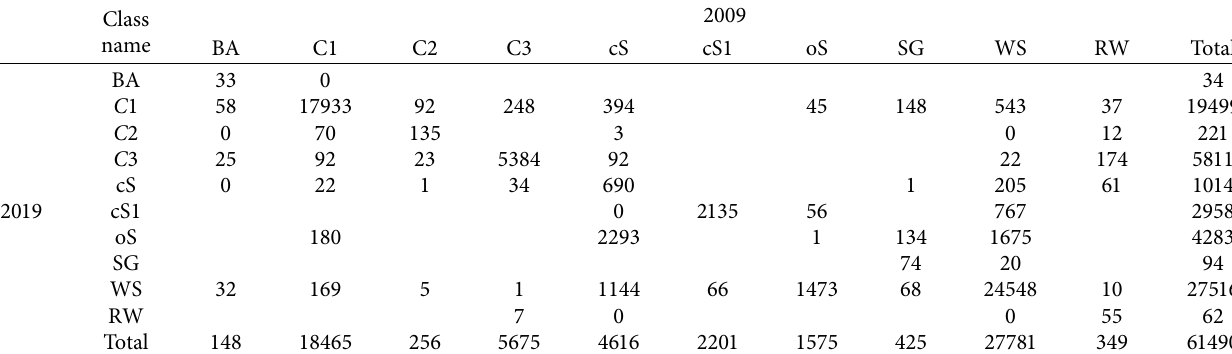
Table 6: LULC change matrix for the period 2009–2019 by